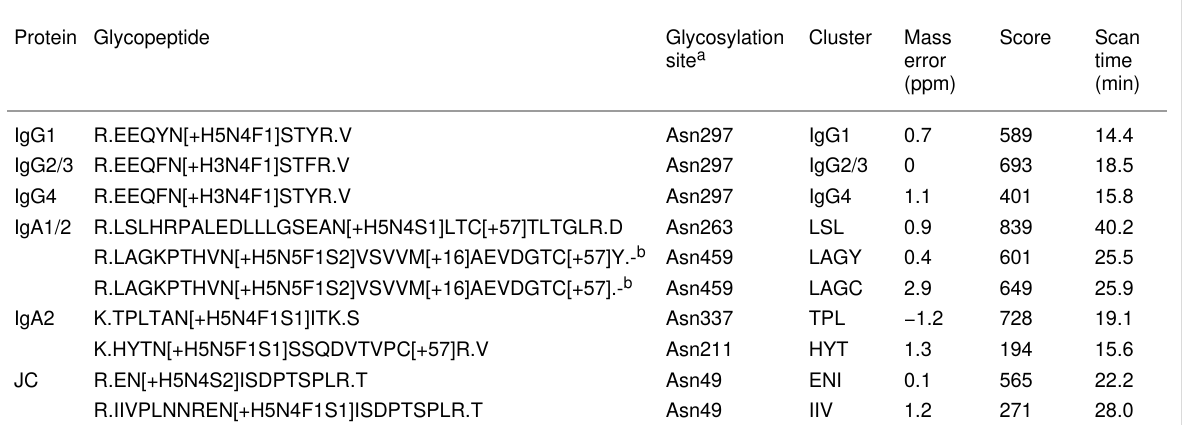
Table 1: Automated MS/MS-based identification of IgG/IgA glycosylation sites by Byonic. For each glycopeptide moiety, a representative glycoform is shown (see Figures S1–S10, Supporting Information File 2 for the corresponding MS/MS spectra).